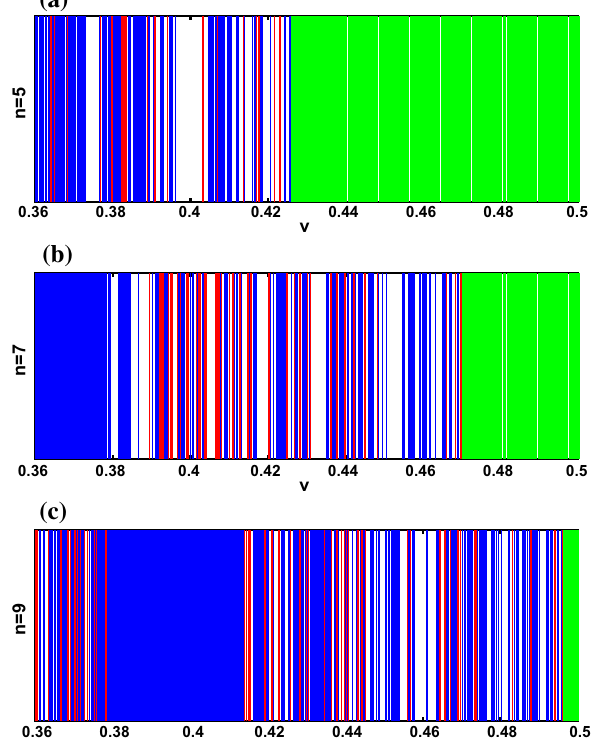
Fig. 10 Kink-antikink collisions: bion state (white), two oscillations (red), three oscillations (blue) and the K ¯ K escapes to the other vacuum (green) for a n = 5, b n = 7 and c n = 9